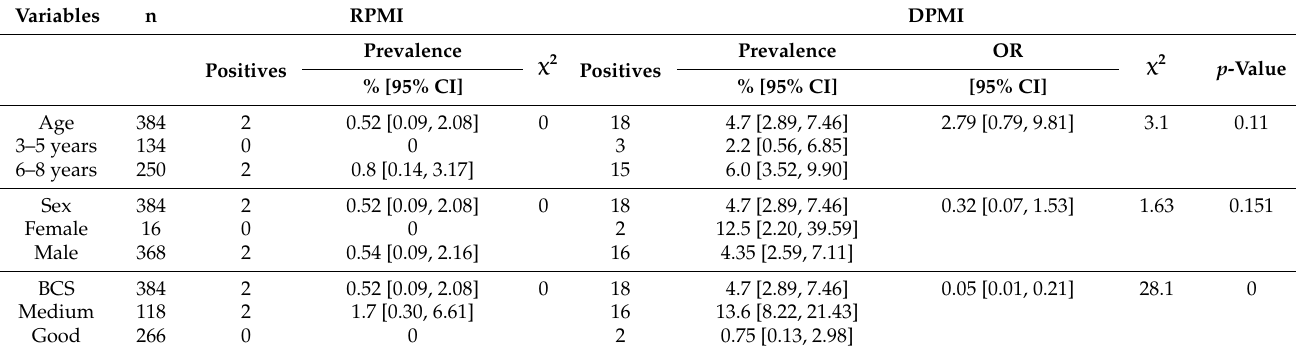
Table 4. Summary of the risk factors in association to postmortem meat inspections.